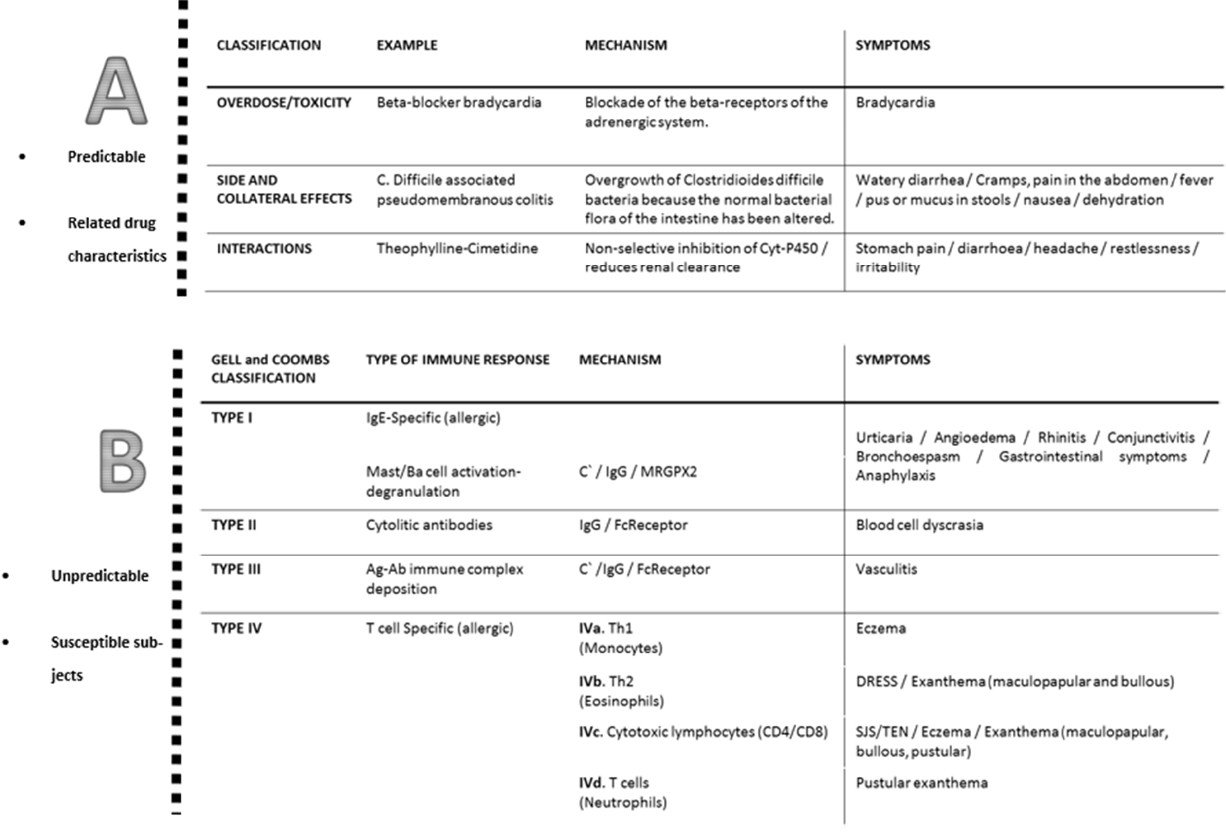
Figure 1. Classification of hypersensitivity reactions to antibiotics.